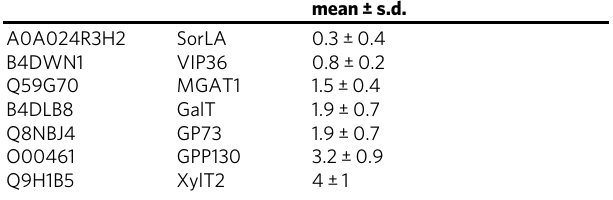
Table 1 List of Golgi transmembrane proteins with AA- sensitive surface localization. In total, there are seven Golgi transmembrane proteins among candidate hits with P value ≤ 0.05 and log 2 (DMEM/HBSS-ratio) ≥ 0.5 or ≤ −